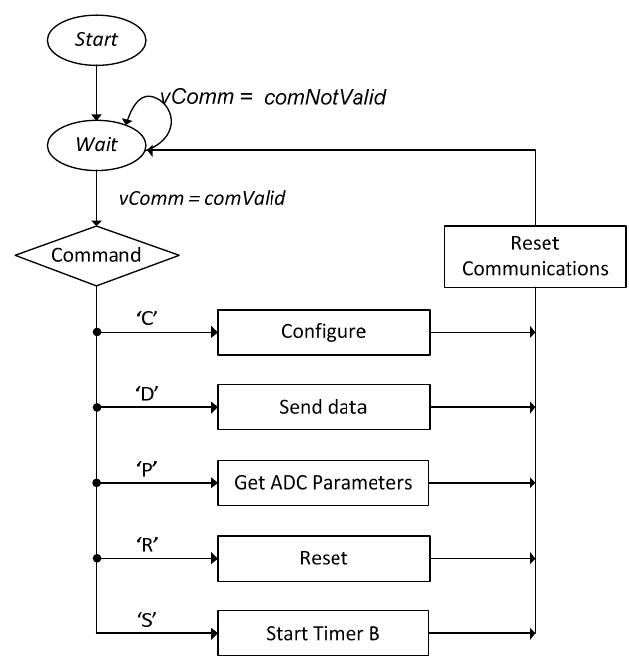
Figure 5. General flowchart of the firmware operation.